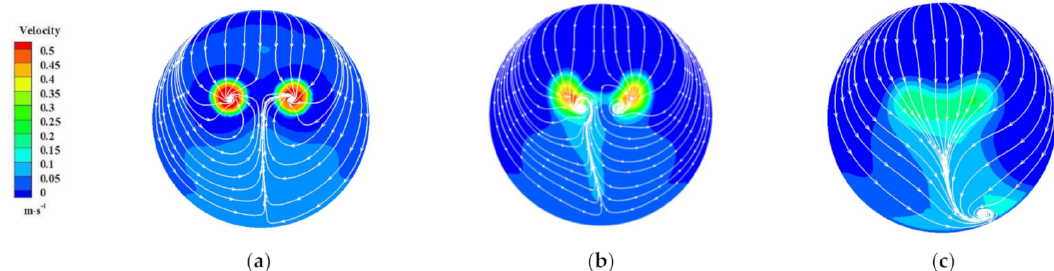
Figure 15. Streamline and velocity nephogram of Section 3-3 of the sump under different H values: ( a ) H = 0.3 D ; ( b ) H = 0.6 D ; ( c ) H = 0.9 D.